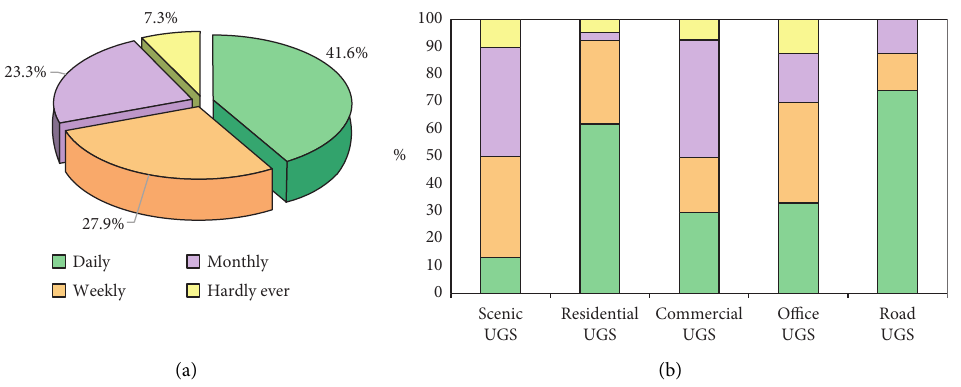
Figure 5: Graph of how often respondents accessed all UGSs (a) and each UGS